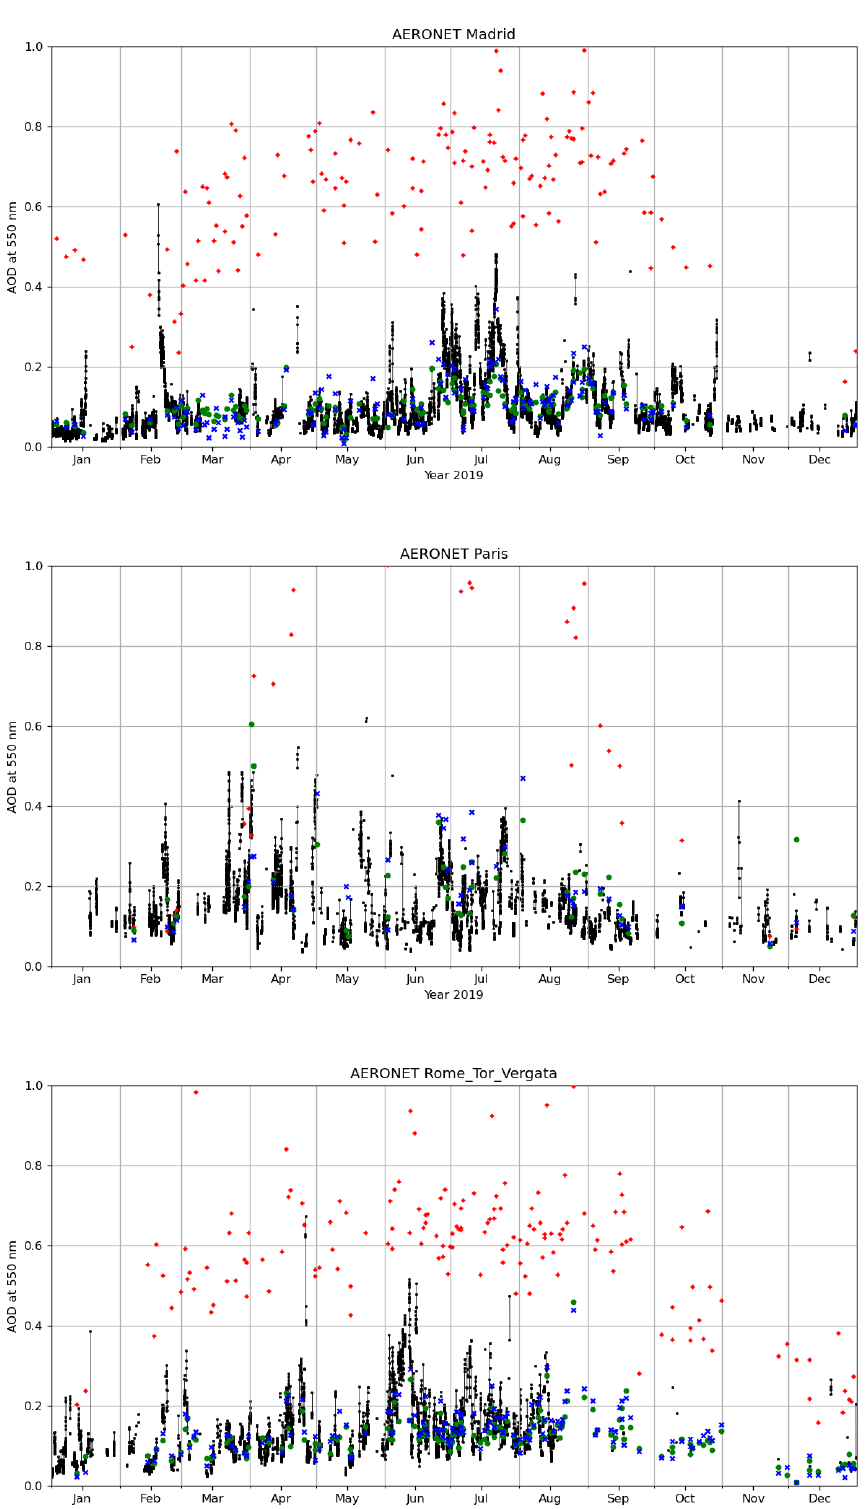
Figure 6. AOD at 550nm time series for three AERONET stations. The black lines and dots indicate AERONET measurements, red diamonds indicate Sentinel-3 Level-2 Synergy, green circles indicate the fully learned regression model, and blue crosses indicate the corrected Sentinel- 3 Synergy